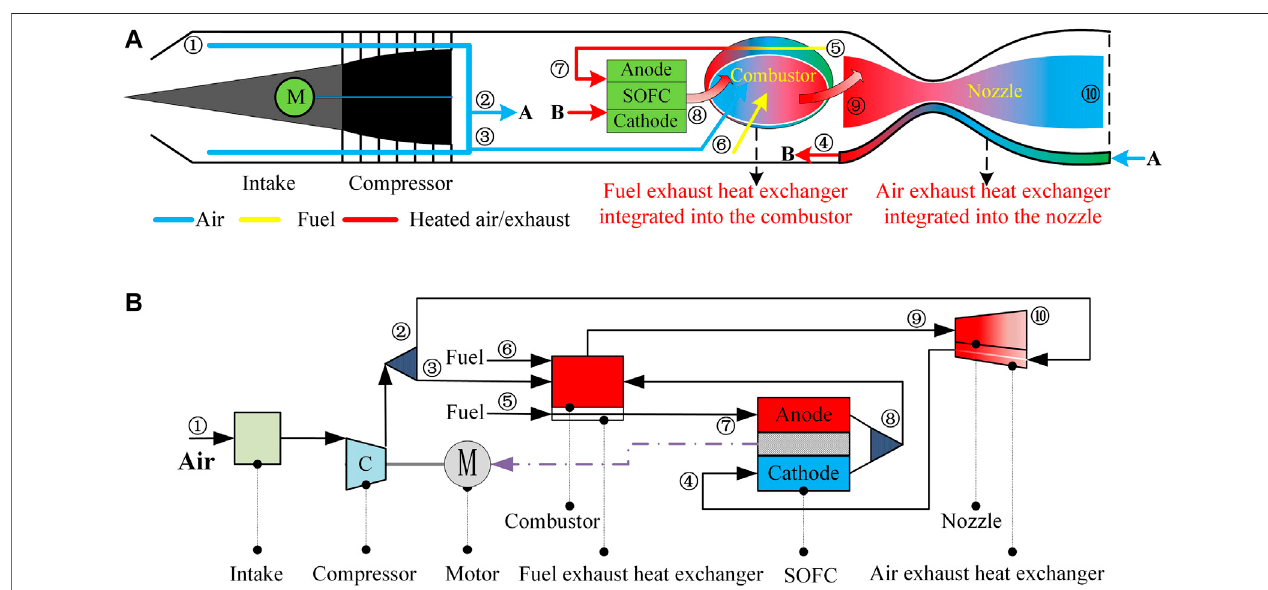
FIGURE 1 | The (A) con fi guration diagram and (B) process fl ow diagram of a compact air-breathing jet hybrid-electric engine coupled with SOFCs.